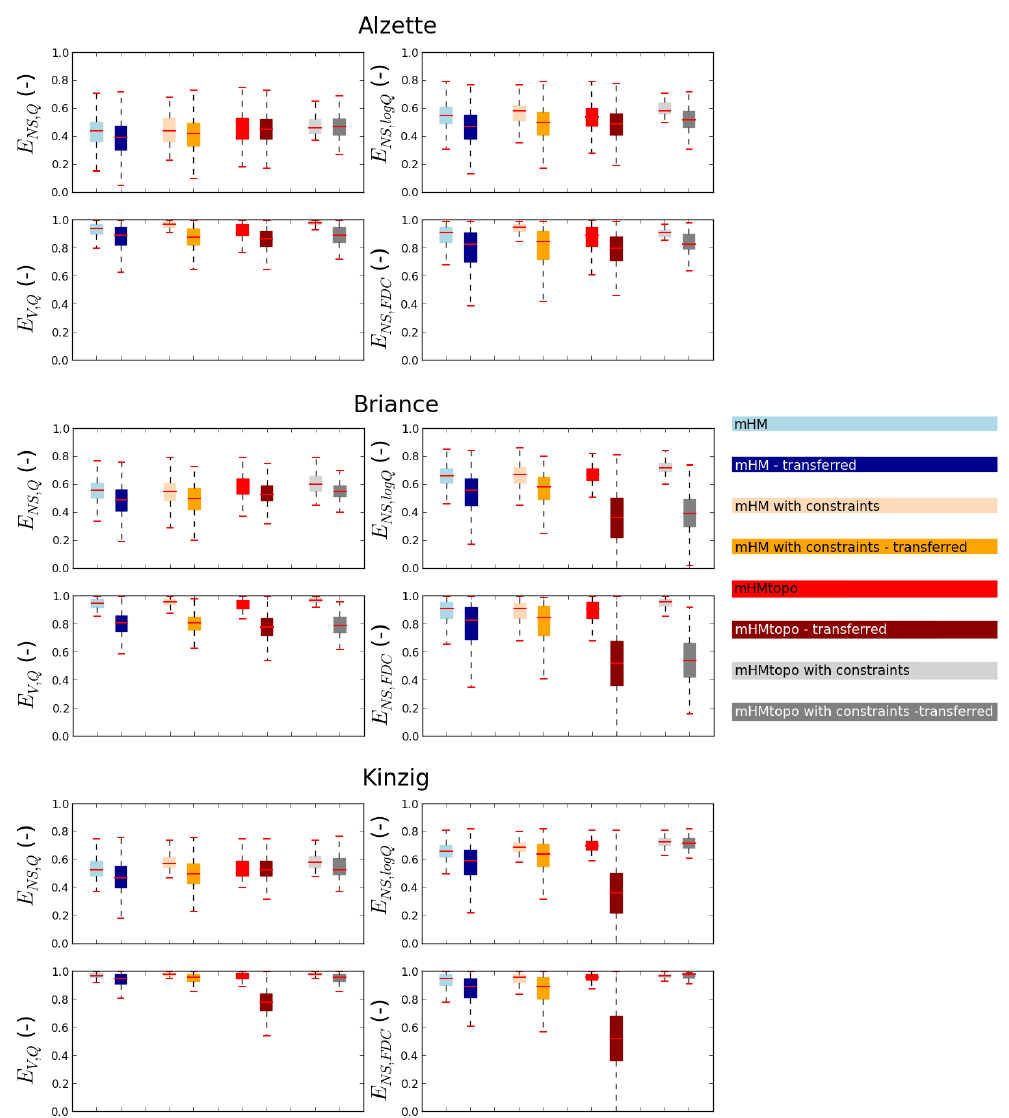
Figure 13. Objective function values of the (a) Alzette, (b) Briance and (c) Kinzig catchments in the validation period for individual calibration (light colours) and when using parameters transferred from the remaining four donor catchments in the multibasin calibration (darker